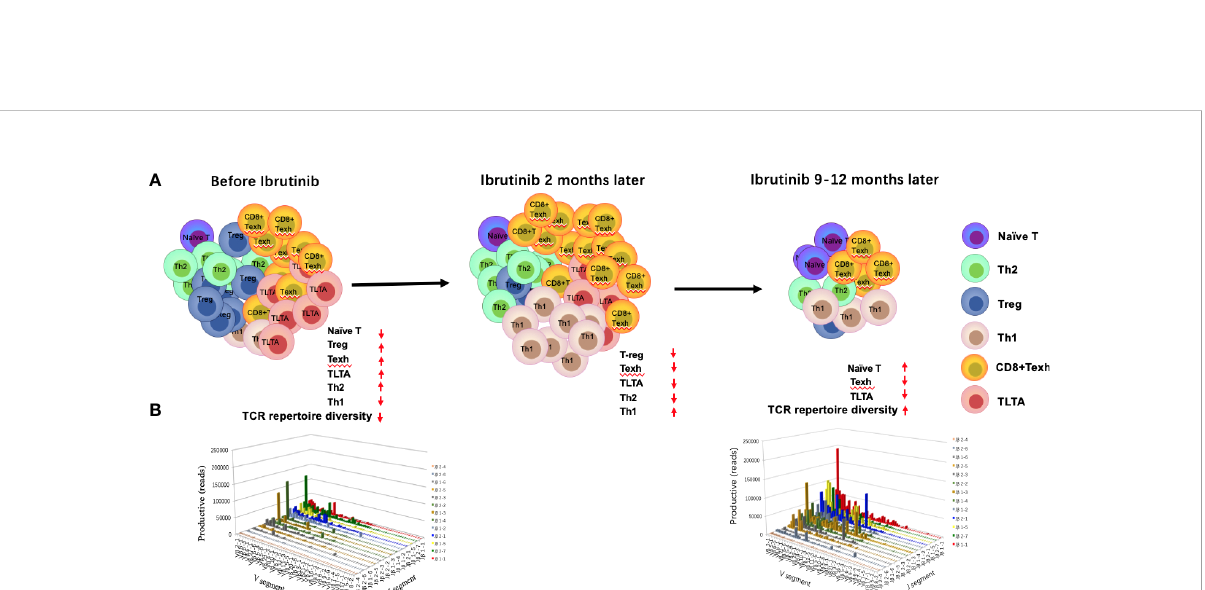
FIGURE 2 Changes in the T-cell compartment and T-cell repertoire before and during ibrutinib treatment. The absolute numbers and percentage of CD4 + and CD8 + T cells increase in the peripheral blood, particularly for CD8 + T cells. However, the distribution of T-cell subgroups is abnormal, which leads to the imbalance of Th1/Th2, an increase in T-regs, long-term activated T cells (TLTAs), and terminally differentiated T cells such as effector memory T cells (T EM ) and exhausted T cells (Texh cells), and a decrease in naïve T cells (A, left penal). There is a severely skewed T-cell repertoire in patients with CLL (B) . After 1 – 2 months of ibrutinib treatment, the number of T cells demonstrates a transient increase and then decreases gradually after 6 months ( (A) middle penal). The distribution of the T-cell subgroups is near to the normal level at 12 months, in parallel with partial reconstruction of the T-cell repertoire diversity [ (A) right penal; (B) ].